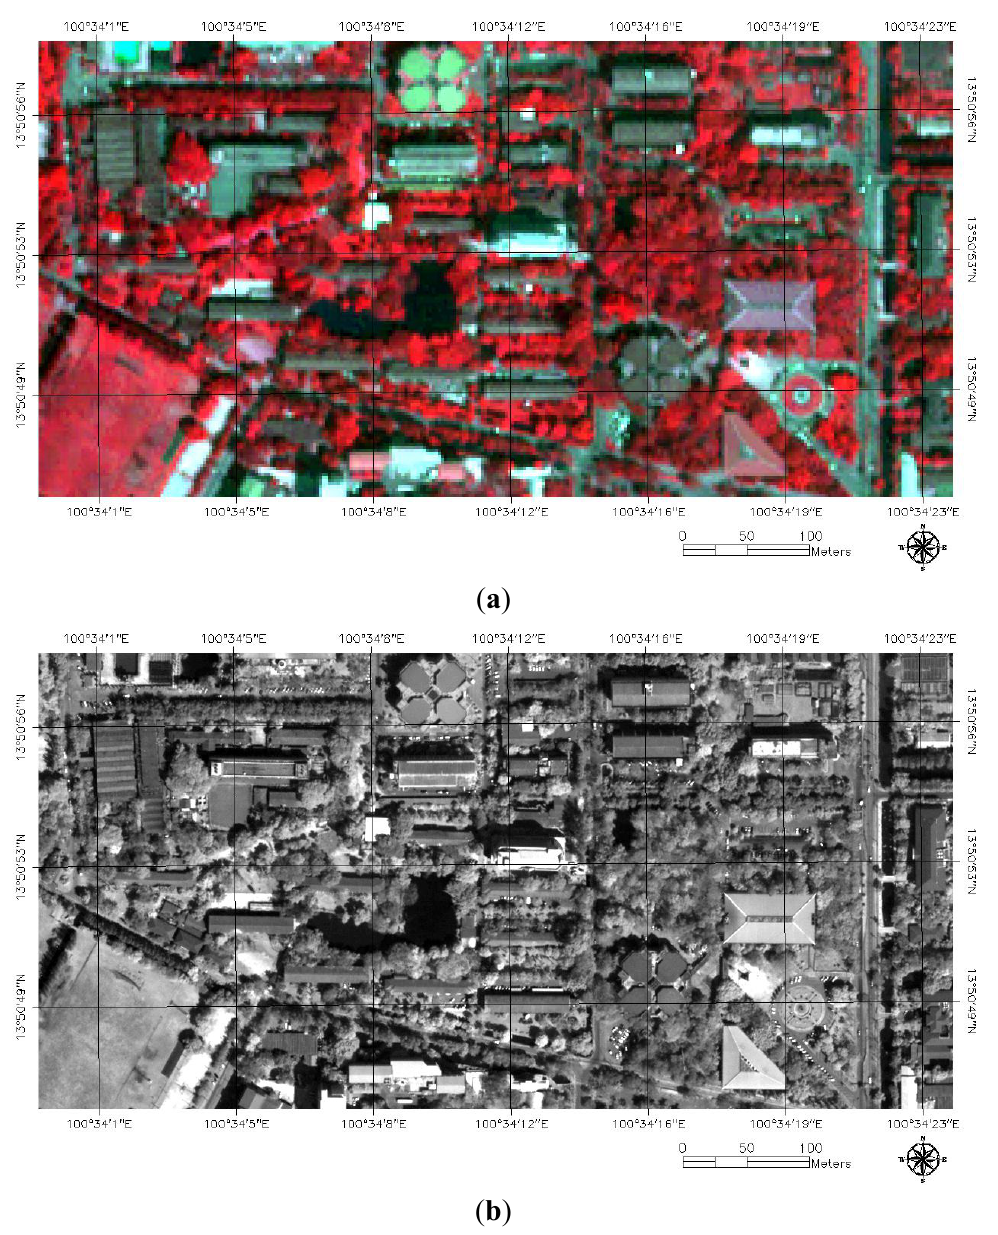
Figure 9. QUICKBIRD dataset of a part of Kasetsart University ( a ) False color composite multispectral image (MI); and ( b ) panchromatic image